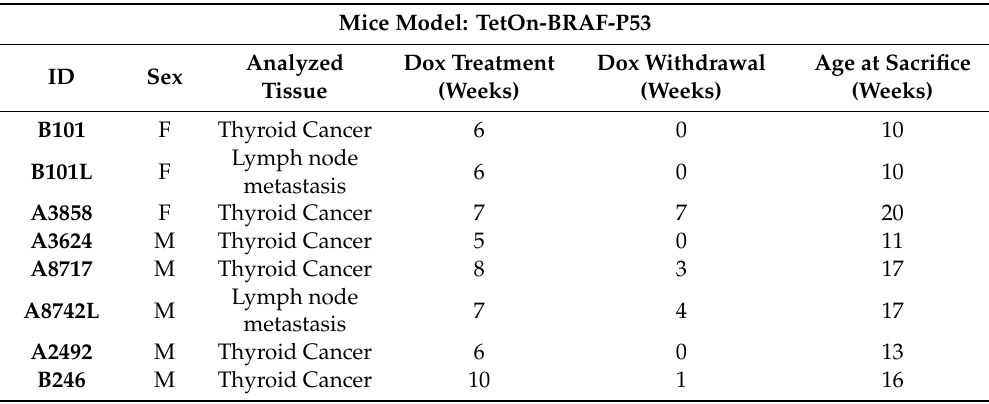
Table 1. Schedule of BRAFV600E dox-induction in TetON-BRAF-P53 mice. Mice Model: